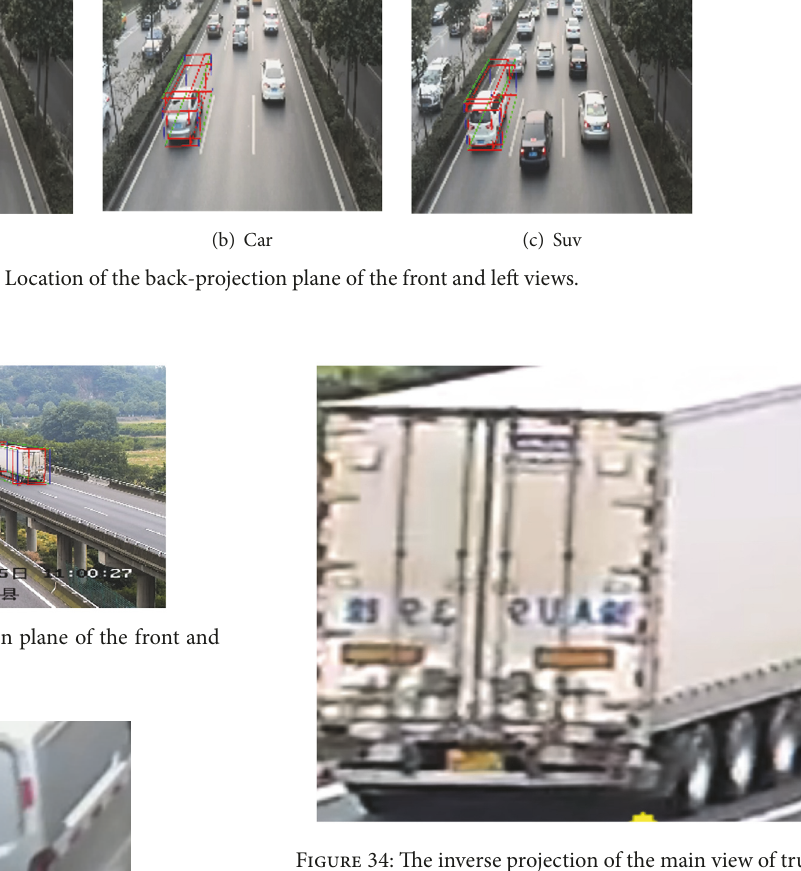
Figure 34: The inverse projection of the main view of truck.